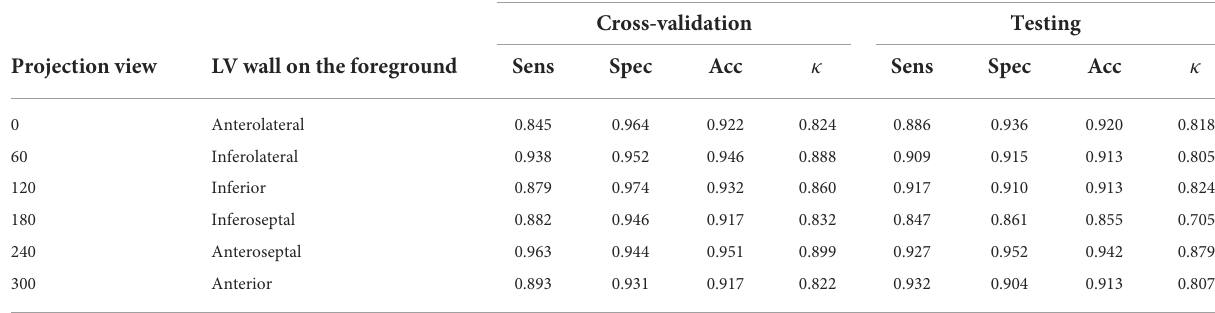
TABLE 3 Results re-binned into six regional LV views.